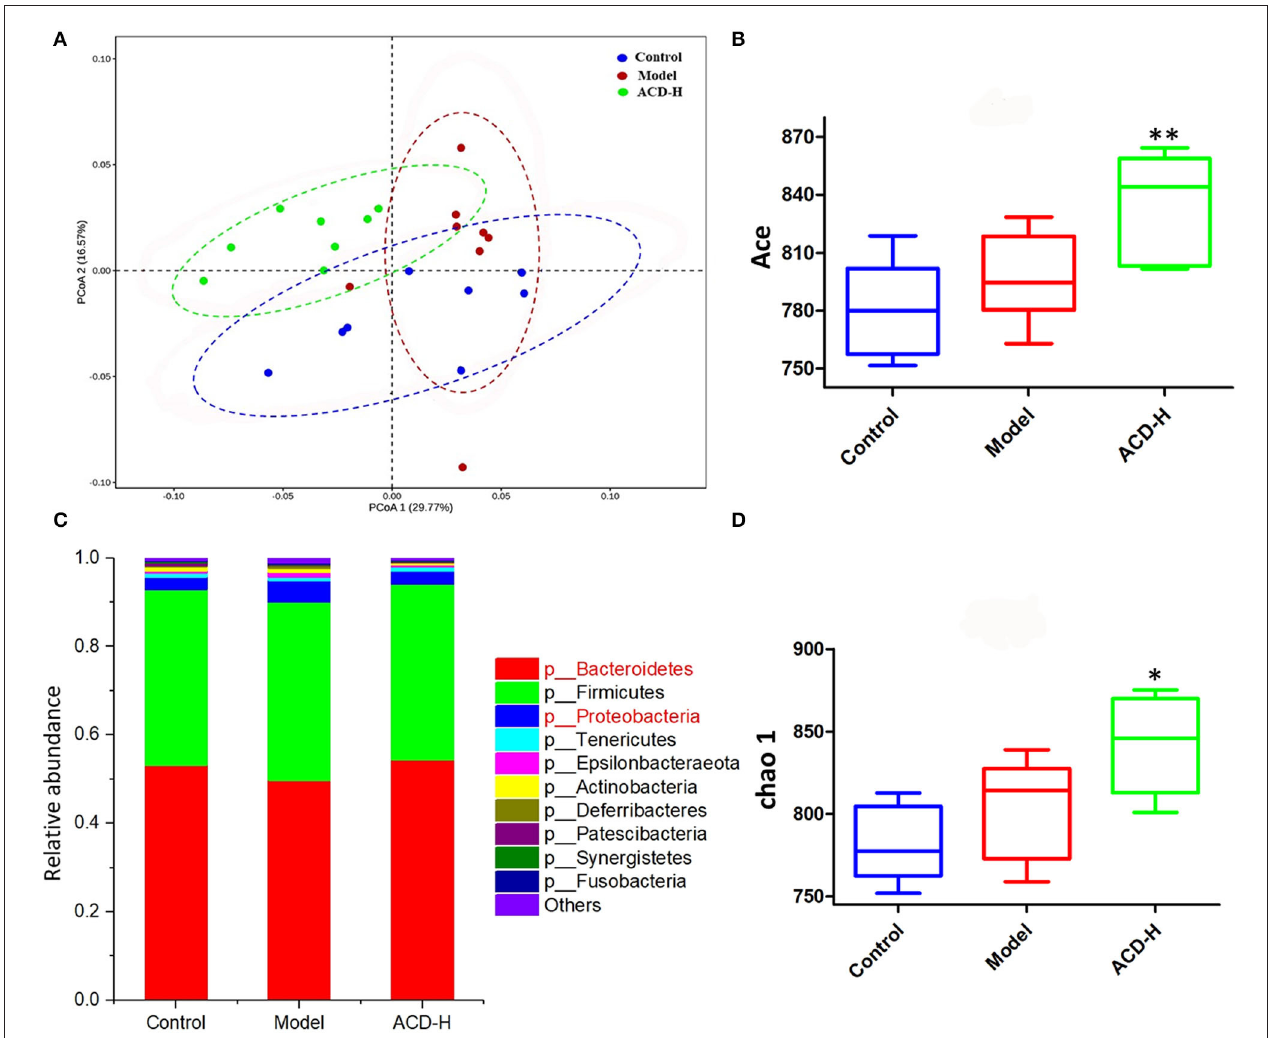
FIGURE 6 | Effects of ACD on gut microbiota in laying hens with FLHS ( n = 8). (A) Weighted-Unifrac distance-based principal coordinate analysis (PCoA) plots of bacterial community structures in the cecal content of laying hens from control, model and ACD-H groups. (B) ACE index in different groups. * P < 0.05, ** P < 0.01, compared with model group. (C) Relative abundances of the gut microbiotas at the phylum level in cecal content in different groups. (D) Chao 1 index in different groups. * P < 0.05, ** P < 0.01, compared with model